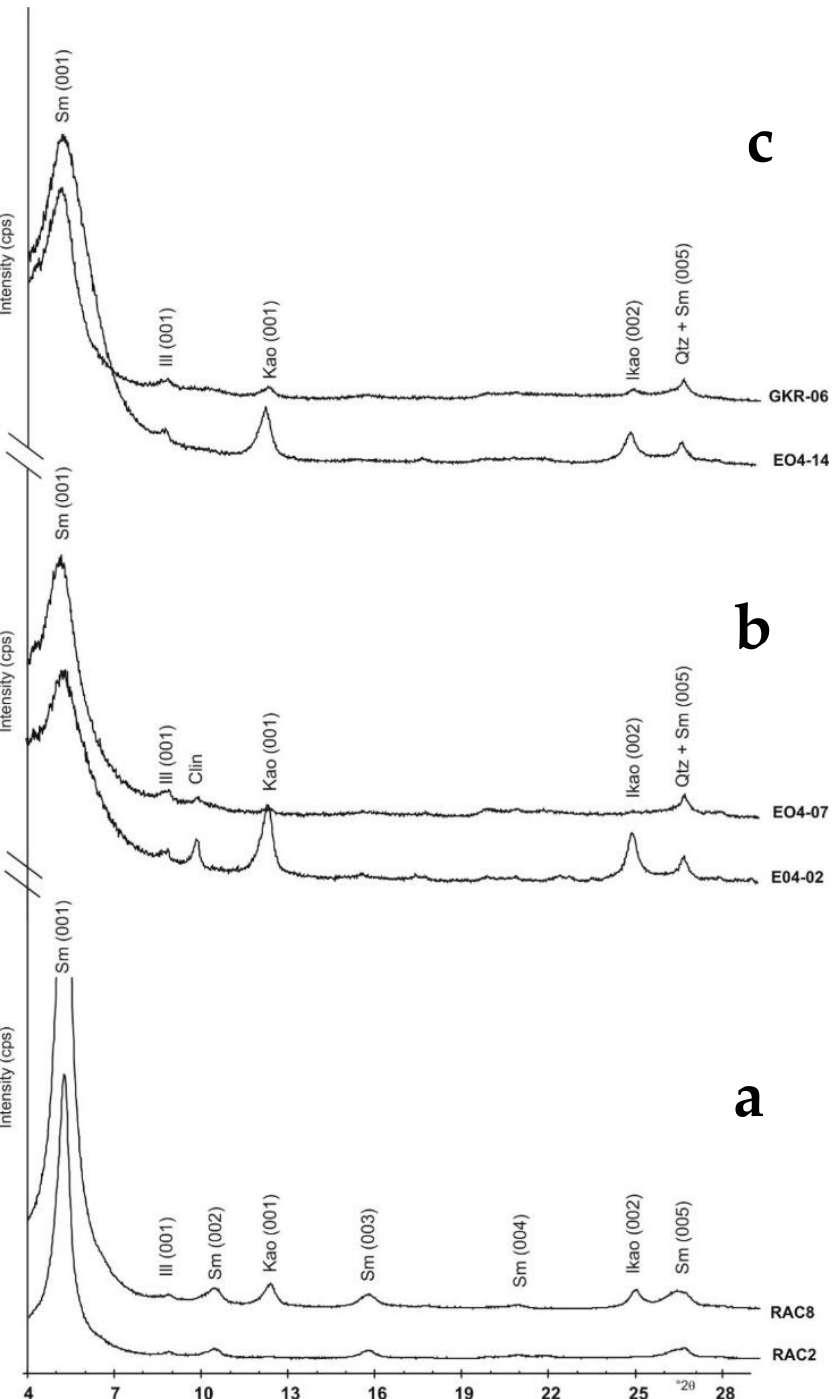
Figure 6. X-ray diffractograms of the clay mineralogy (<2 μm fraction) analysed as glycolated oriented mounts and using Cu–Kα radiation, °2θ on the horizontal axis, and counts per second (cps) on the vertical axis. ( a ) the Moreno Fm, ( b ) the Lower Kreyenhagen, and ( c ) the Upper Kreyenhagen. Mineral abbreviations are as in Table 1. Sample locations are shown in Figure 3.